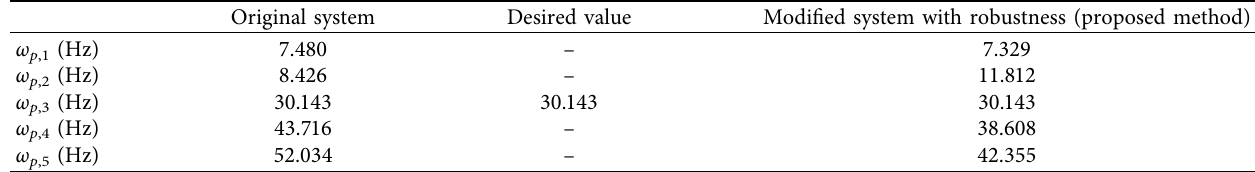
Table 11: Test-case 3: original, desired, and modified system lower natural frequencies.